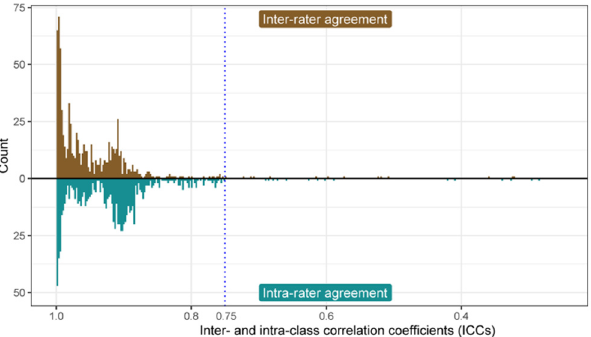
Figure 3. Bar plots of intra- and inter-observer ICC. Upper: inter-rater agreement; Lower: intra-rater agreement. ICC: intra-class correlation coefficient.